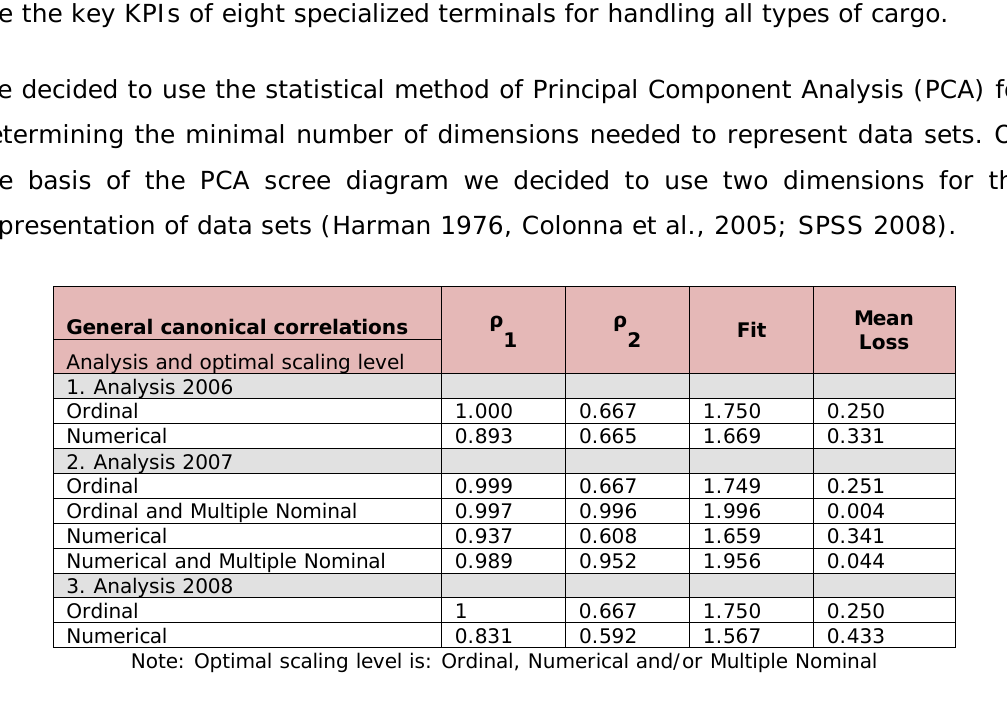
Table 4. “General canonical correlations, Fit and Mean